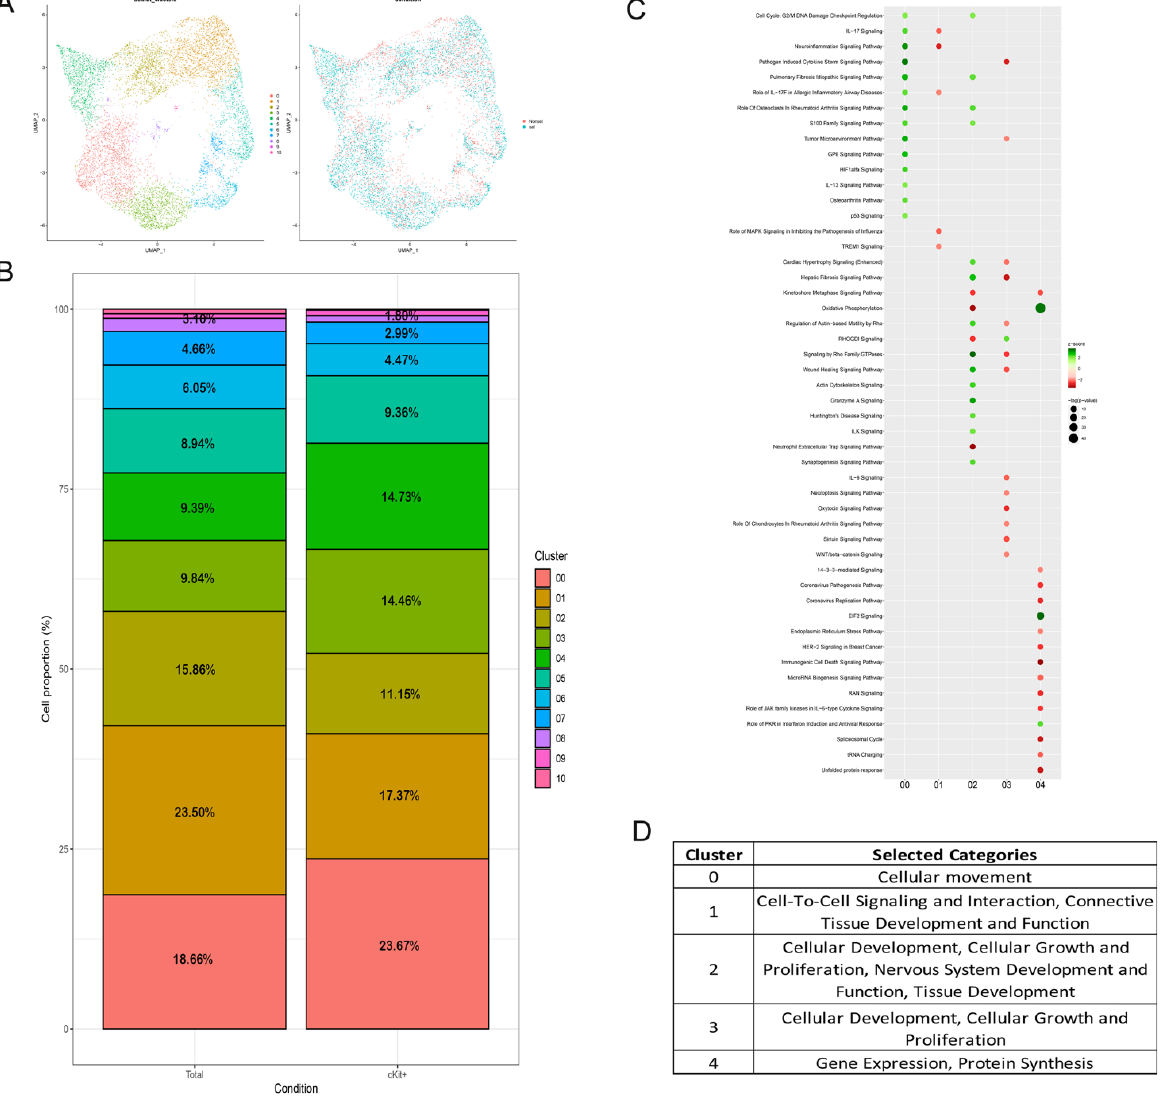
Figure 2. Total amniotic fluid cells and selected for c-Kit: comparison of the transcriptomic profile with single cell analysis. ( A ) UMAP plot displaying the number of identified hAFSC clusters and the distribution of cells belonging to the two different conditions. ( B ) Percentage of cells in each identified cluster with respect to the total number of purified cells in the total (on the left) and c-Kit + sample (on the right). ( C ) Ingenuity pathway analysis performed on the class-specific markers of the five most abundant clusters: upregulated pathways in c-Kit + cells are in green, while downregulated pathways are in red. ( D ) Selected categories identified with IPA analysis using specific markers of the first five most abundant clusters.